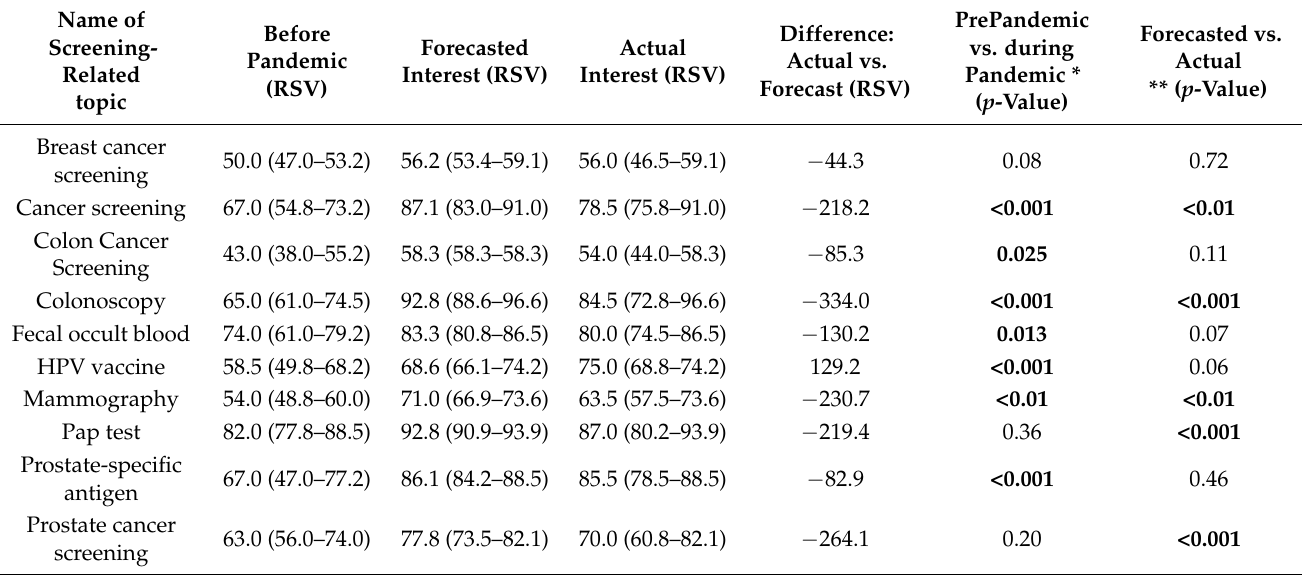
Table 1. Global statistics of Google queries on the chosen cancer screenings and HPV vaccine.